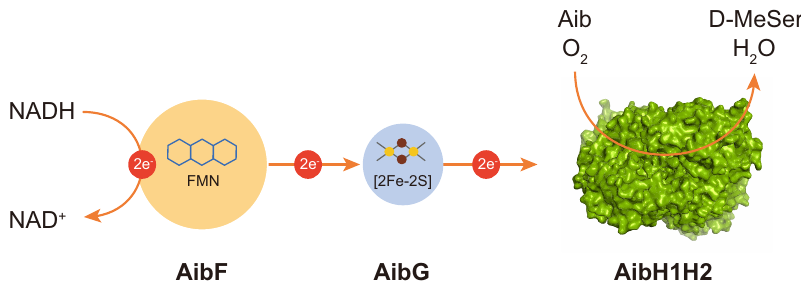
Fig. 3 The three-component enzyme system used for the hydroxylation of Aib to produce D -MeSer in R. wratislaviensis C31-06. The electron pair of NADH is transferred to the hydroxylase component (AibH1H2) via electron transfer proteins (AibF and AibG). AibH1H2 catalyzes the hydroxylation of Aib to produce D -MeSer together with water, by using the received electron pair and molecular oxygen. AibF, ferredoxin:NAD + oxidoreductase; AibG, ferredoxin; AibH1H2, α 2 α ′ 2 heterotetrameric Aib